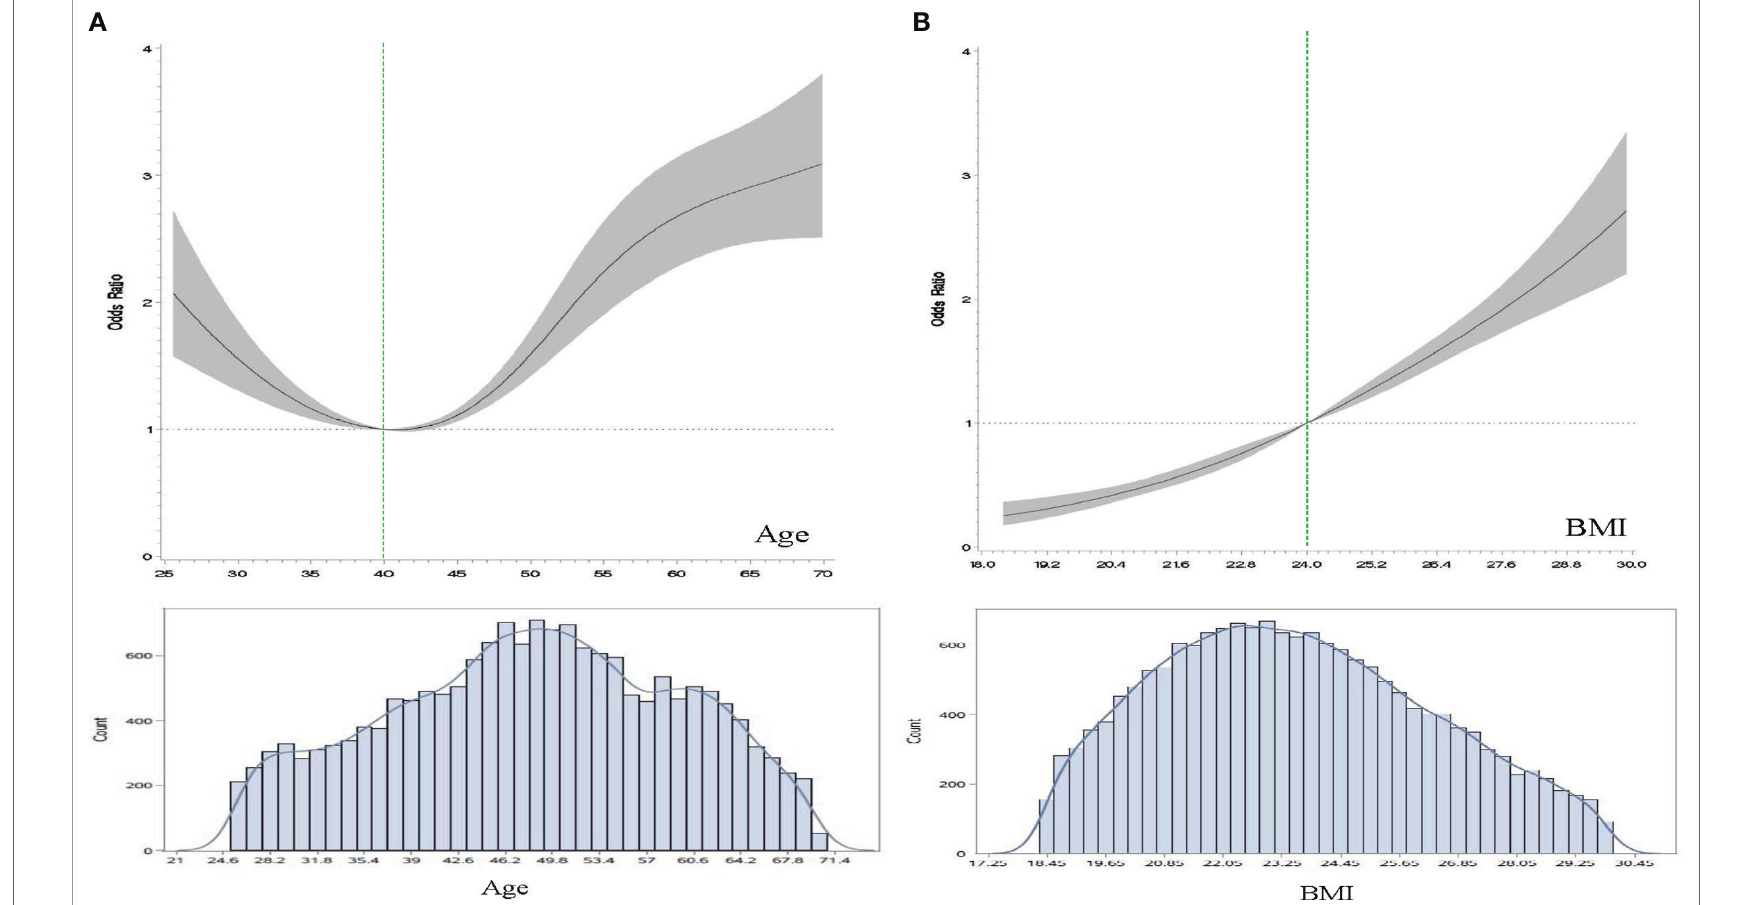
FIGURE 2 | The dose-response relationships of age, BMI with the odds ratios (OR) of hyperuricemia using restricted cubic spline (RCS) modeling. (A) , The association between age and hyperuricemia. The model was adjusted for body mass index (BMI, kg/m 2 ), residential areas, educational levels, study sites and alcohol drinking status. (B) , The association between BMI and hyperuricemia. The model was adjusted for age, residential areas, educational levels, study sites, and alcohol drinking